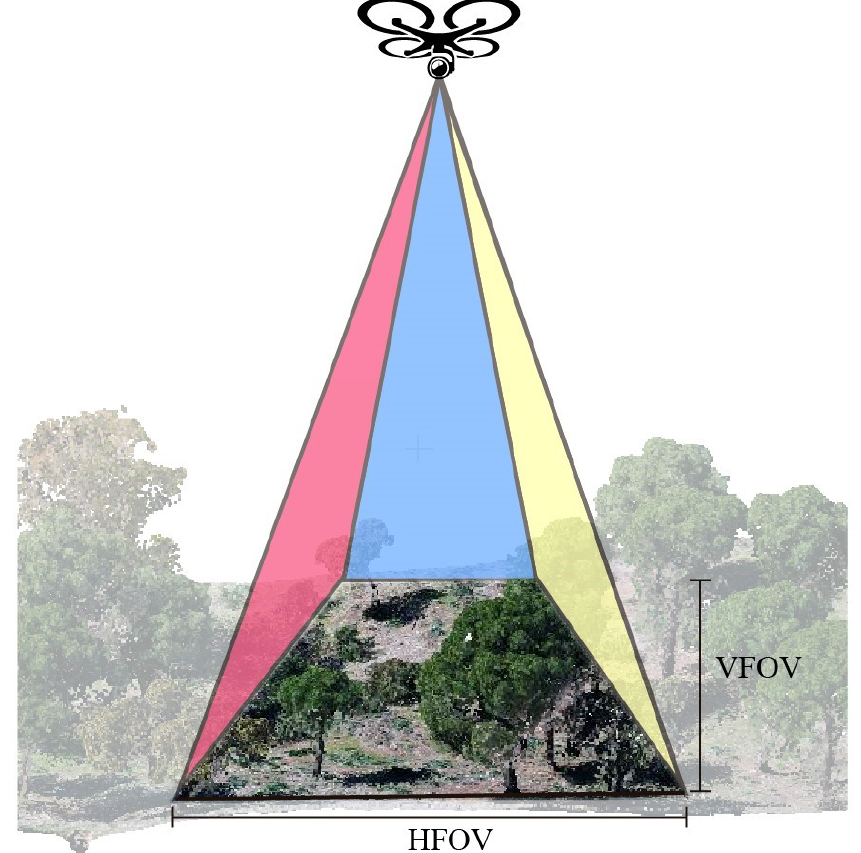
Figure 5. The 3D space of the point cloud which is covered from a multispectral